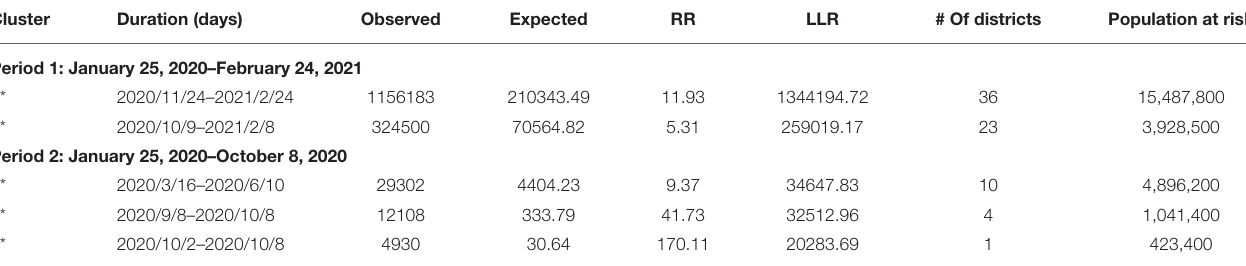
TABLE 1 | Space-time clusters of COVID-19 cases from January 25, 2020 to February 24, 2021 at the district level. Cluster Duration (days) Observed Expected RR LLR # Of districts Population at